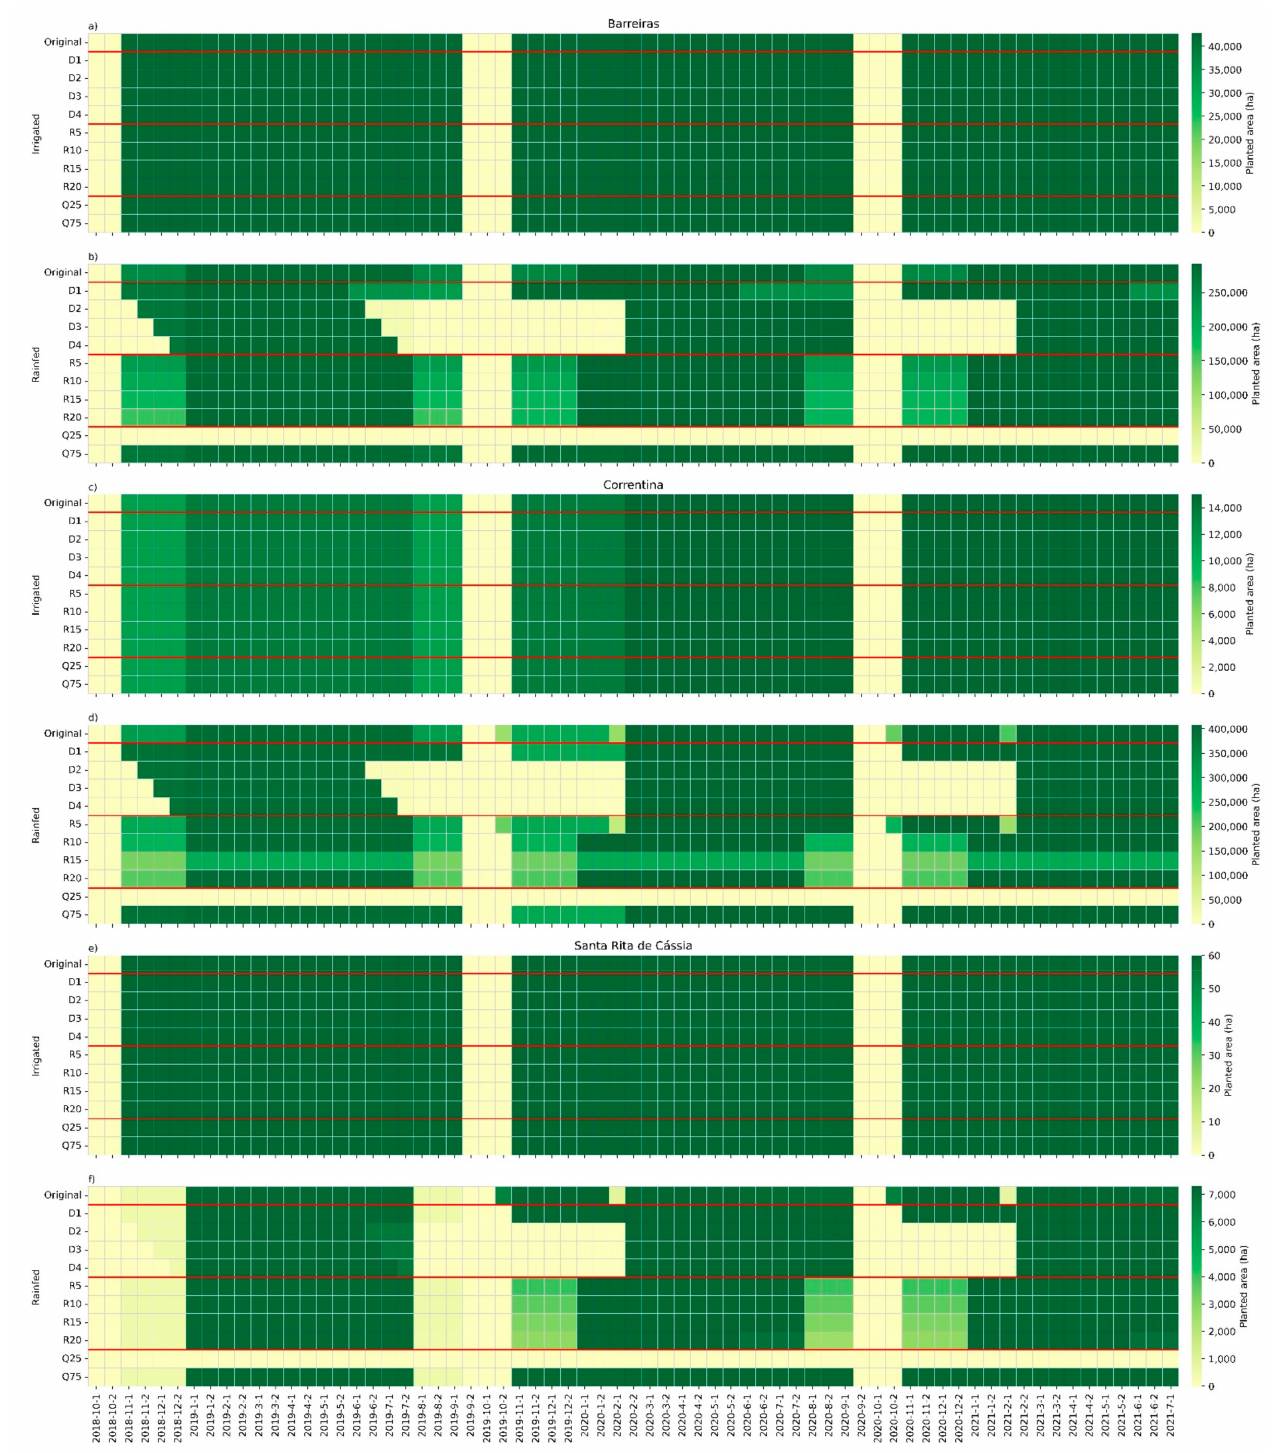
Figure 8. Planted area, in hectares, recommended by LPM application for irrigated and rainfed conditions of Barreiras, Correntina, and Santa Rita de C á ssia. ( a ) Shows the results for irrigated areas of Barreiras. ( b ) Shows the results for rainfed areas of Barreiras. ( c ) Shows the results for irrigated areas of Correntina. ( d ) Shows the results for rainfed areas of Correntina. ( e ) Shows the results for irrigated areas of Santa Rita de C á ssia. ( f ) Shows the results for rainfed areas of Santa Rita de C á